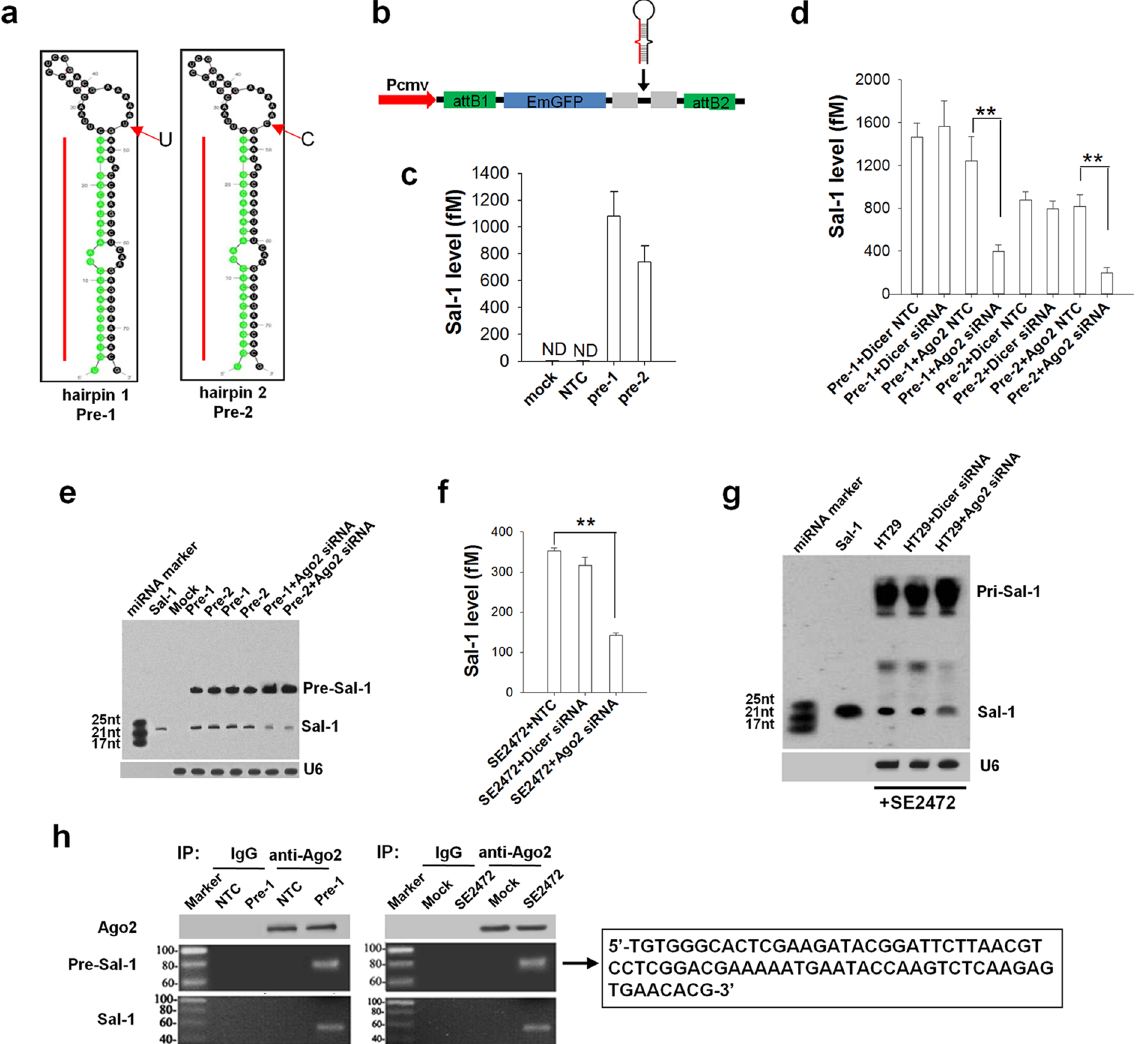
Figure 3. Biogenesis of Sal-1 in the Salmonella –infected HT-29 cells is AGO2-dependent. ( a ) Prediction of putative hairpin structure of Pre-Sal-1 for the biogenesis of mature Sal-1. ( b ) Construction of pcDNATM6.2-GW/EmGFP vector expressing Pre-Sal-1. Pre-Sal-1 was inserted immediately downstream of GFP and promoted by the CMV promoter. ( c , e ) Mature Sal-1 in HT-29 cells transfected with two Pre-Sal-1 expression plasmids (Pre-1 and Pre-2) detected by qRT-PCR (c ) and northern blot analysis ( e ). ( d ) qRT-PCR detection of Sal-1 level in Pre-1- or Pre-2-transfected HT-29 cells with or without Dicer or Ago2 silence. ( e ) Northern blot analysis of Sal-1 in Pre-1- or Pre-2-transfected HT-29 cells with or without Ago2 silence. ( f ) qRT- PCR detection of Sal-1 level in SE2472-infected HT-29 cells with or without Dicer or Ago2 silence. ( g ) Northern blot of Sal-1 and Pre-Sal-1 in SE2472-infected HT-29 cells with or without Dicer or Ago2 silence. ( h ) RT-PCR amplification of Pre-Sal-1 and mature Sal-1 that are associated with AGO2 complex in HT-29 cells directly infected with SE2472 or transfected with Pre-Sal-1. Pre-Sal-1 was amplified, inserted into a T-vector and sequenced. The data are presented as the mean ± SEM (n = 3). ** P < 0.01. ND, not